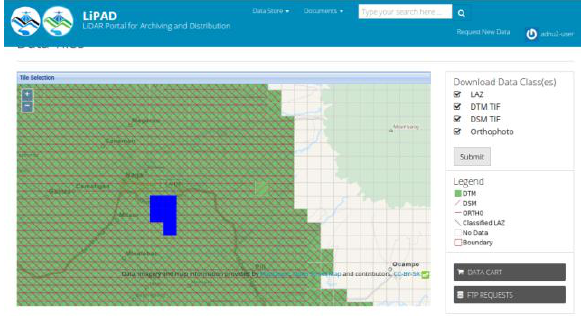
Figure 7. Tile Based DEM Data Coverages in LIPAD